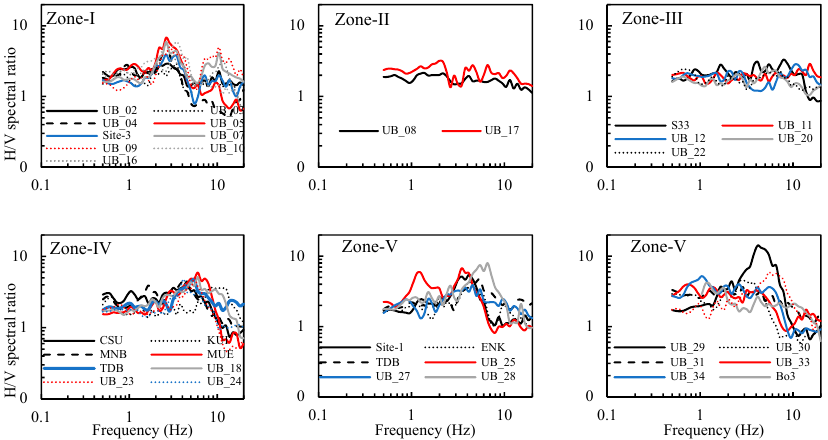
and ( c ) 6.67–10 Hz.